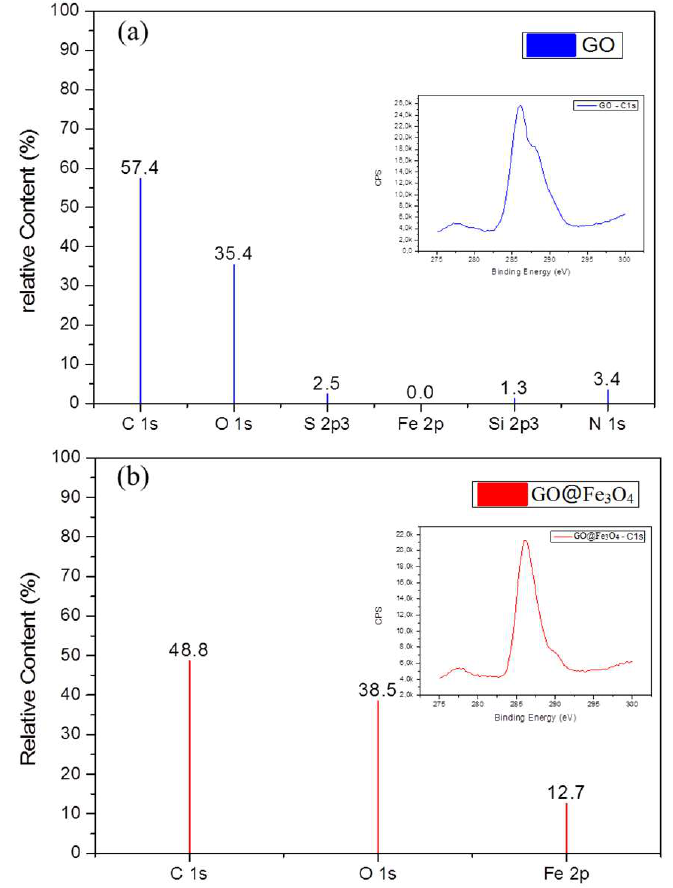
Figure 5. Compositions and C1s profiles of GO ( a ) and GO@Fe 3 O 4 ( b ) powders measured by X-ray photoelectron spectroscopy (XPS).